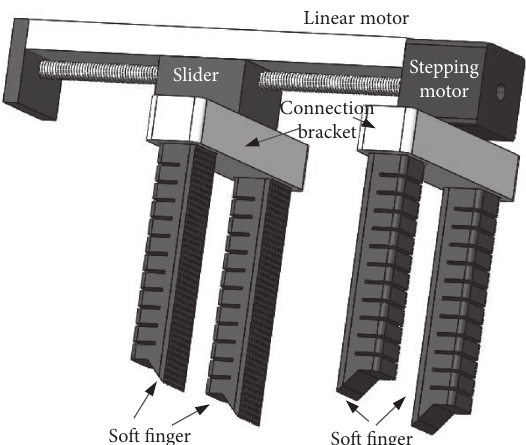
Figure 5: Overall design structure diagram of the gripper. Table 1: Material properties. Shore